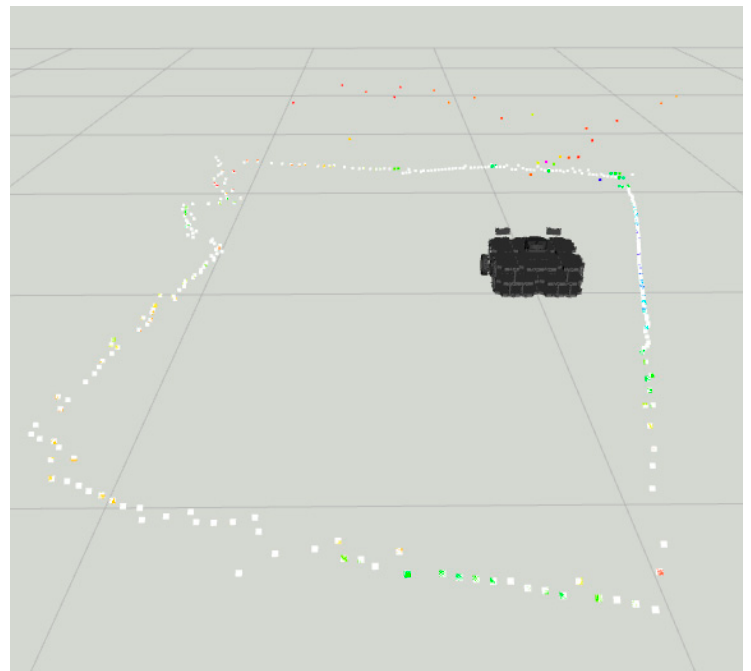
Figure 30. Pre and post fusion readings for LiDAR-Sonar fusion using curtain mesh as main obstacle.